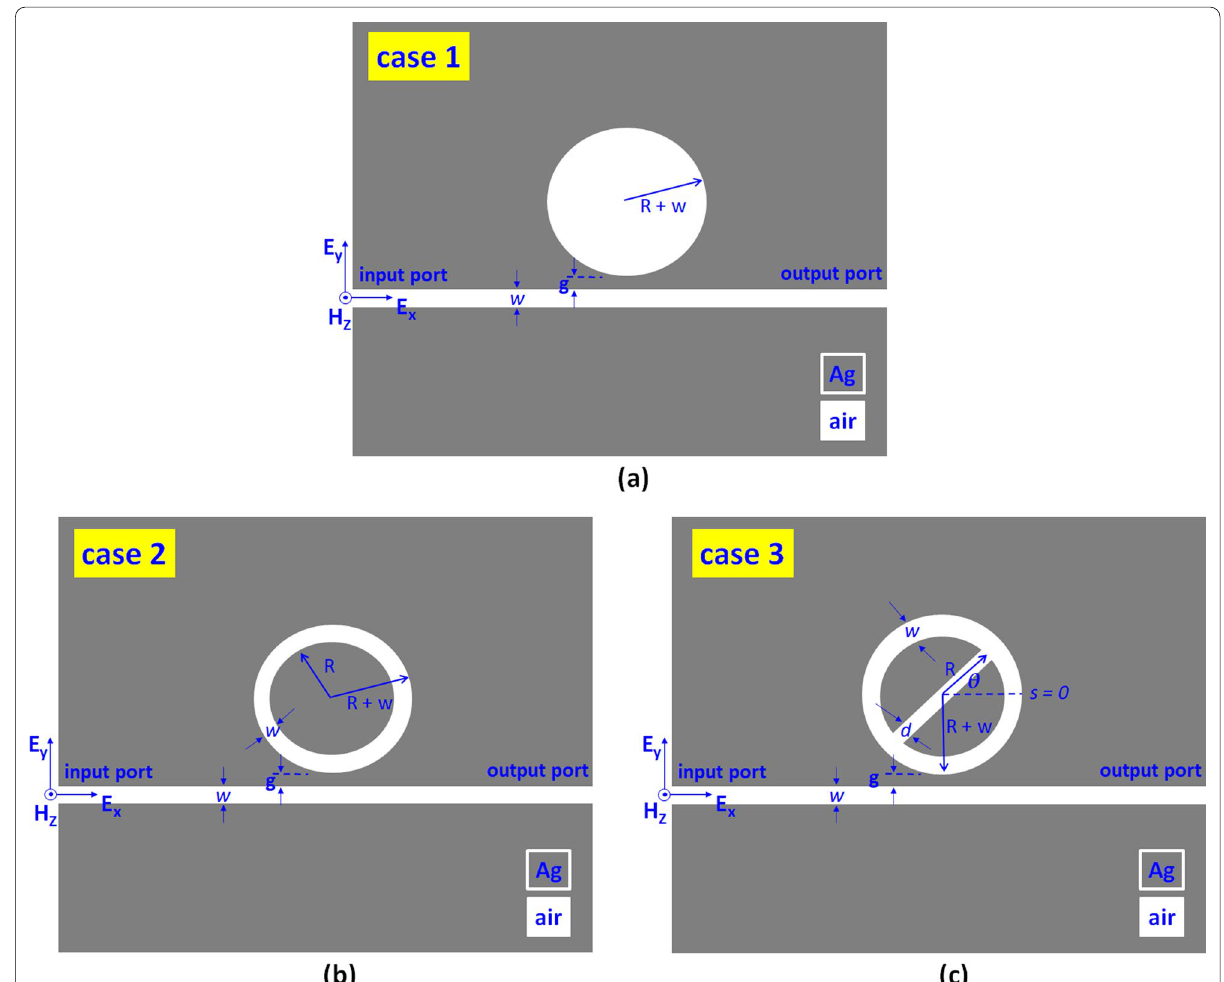
Fig. 1 Top view of the investigated plasmonic sensors, consisting of a MIM bus waveguide coupled with one circular ring‑shaped cavity. a case 1: without an inner core, b case 2: with an inner core, and c case 3: with an air path in the inner core,